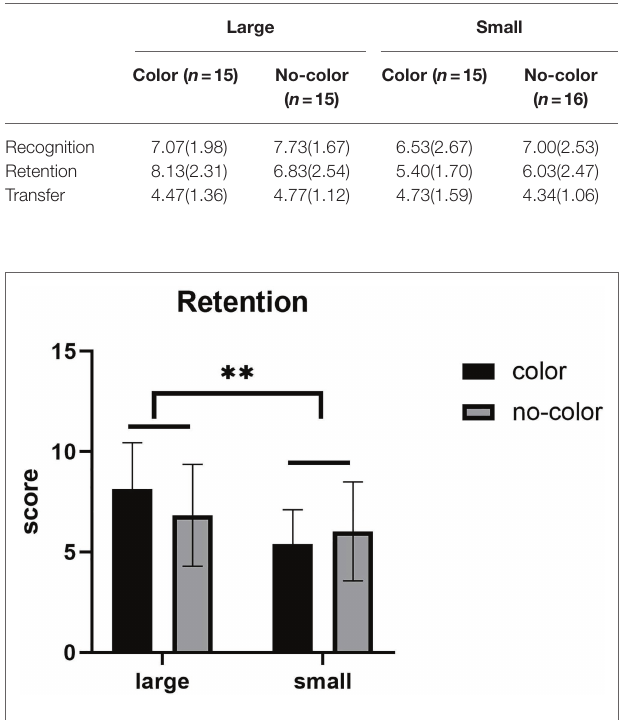
FIGURE 2 | Mean of retention test. Error bars represent standard errors of the means ( ** p <